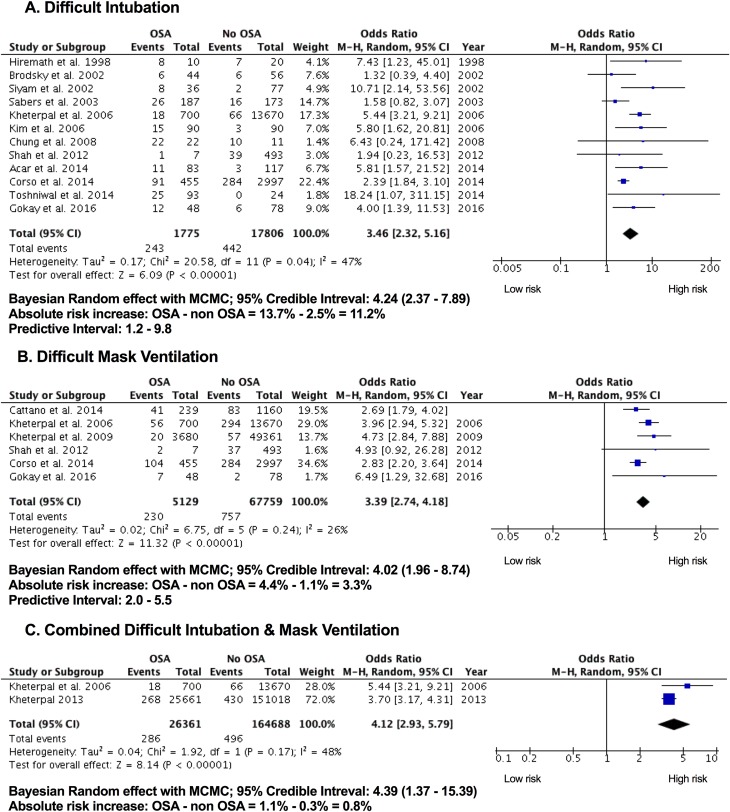
Meta-analysis of difficult airway between OSA and non OSA patients undergoing surgery.The odds ratio of each included study is plotted. A pooled estimate of overall odds ratio (diamonds) and 95% confidence intervals (width of diamonds) summarizes the effect size using the random effects model. CI = confidence interval; M-H: Mantel-Haenszel; OR = Odds ratio; OSA = obstructive sleep apnea.